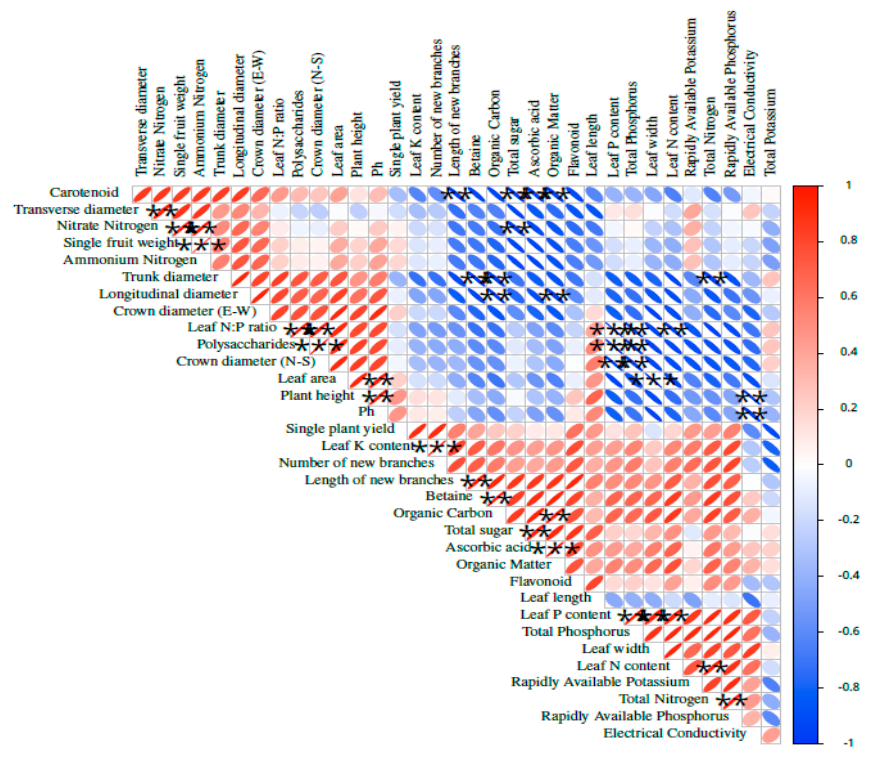
Figure 4. Correlation analysis of plant growth under different root − restriction cultivation methods. Note: One, two and three asterisks represent significance at p < 0.05, p < 0.01 and p < 0.001, respectively.